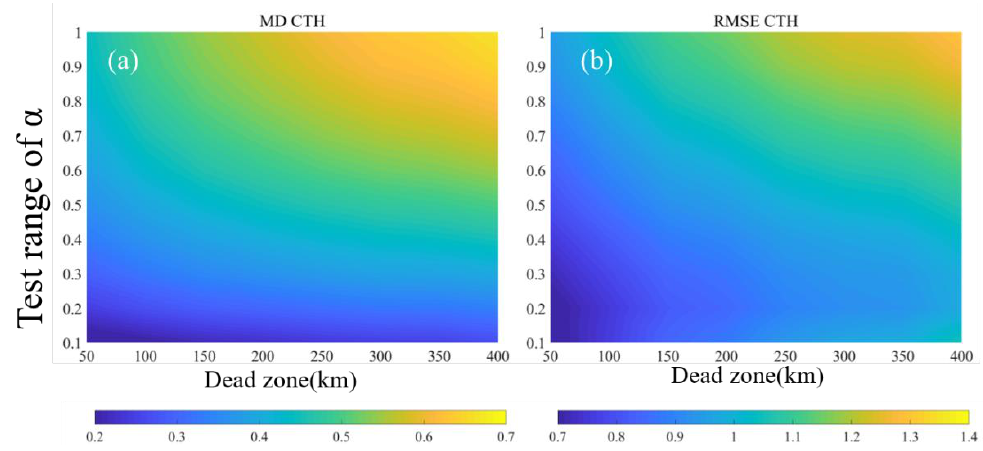
Figure 6. MD (a) and RMSE (b) of MODIS CTH between the original pixels and the reconstructed pixels, changing with α and dead zone.